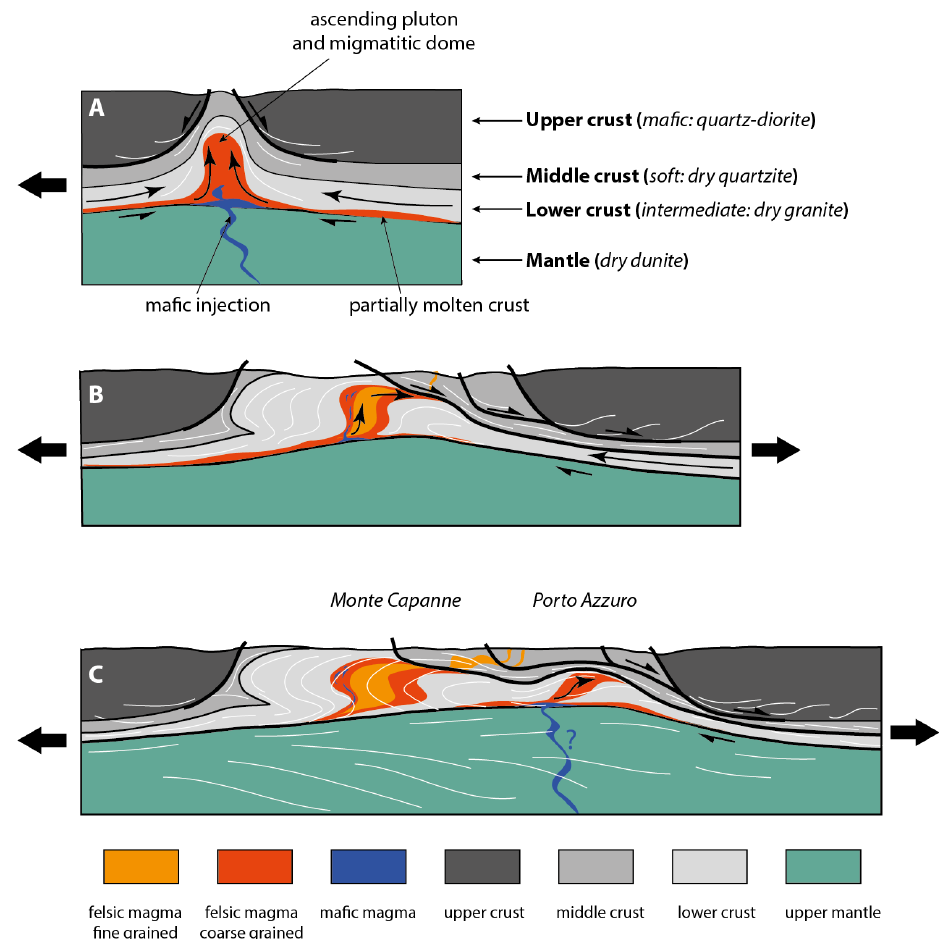
Figure 14. Conceptual model of the succession of events leading to the emplacement of a plutonic system below an active series of detach- ments, based on Huet et al. (2011) and Schubert et al.